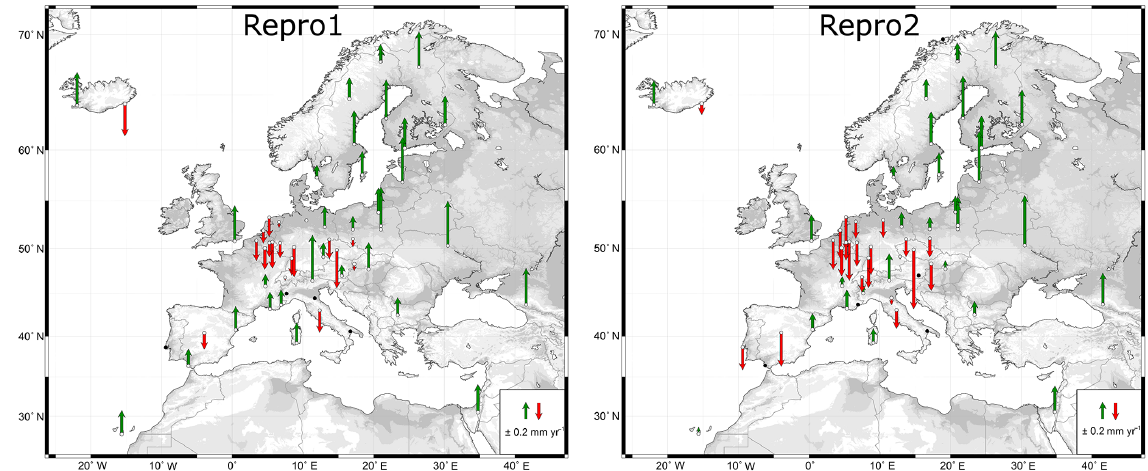
Figure 5. ZTD trend for 16-year time series (January 1998 to December 2013) obtained from the Repro1 campaign (left) and ZTD trend for 16-year time series (January 1998 to December 2013) obtained from the Repro2 campaign